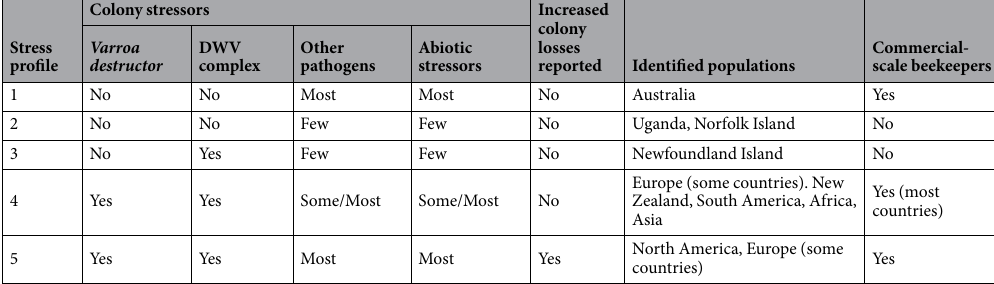
Table 3. Five stress profiles identified across comparable studies of global A. mellifera populations compiled as part of a semi-systematic review (see Supplementary material 4). Profiles are characterised by the presence or absence of known or hypothesized causes of increased honeybee colony losses. In relation to Fig. 4, populations with profiles 1–3 are on the lower end of the stress spectrum, populations with profile 4 range across the middle of the stress spectrum and populations with profile 5 are on the high end of the stress